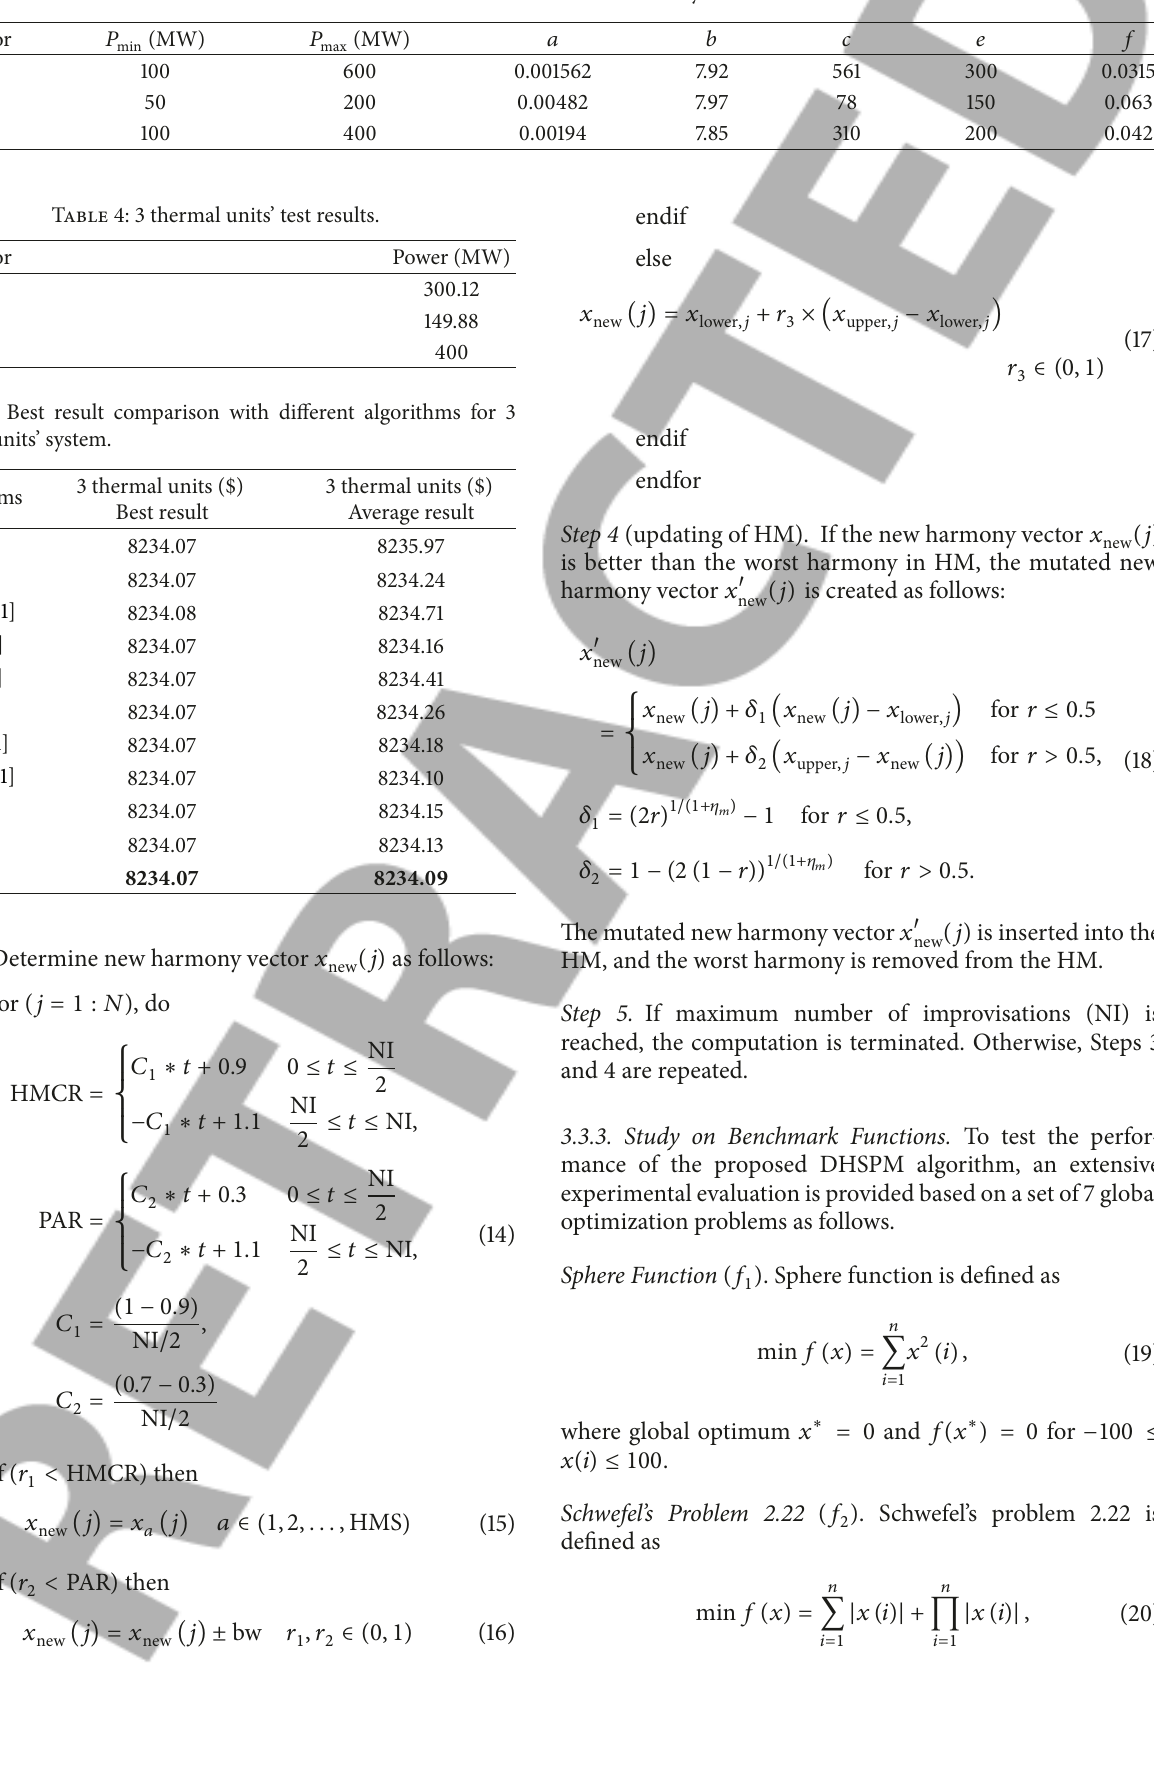
Table 3: Units data for 3 thermal units’ system.